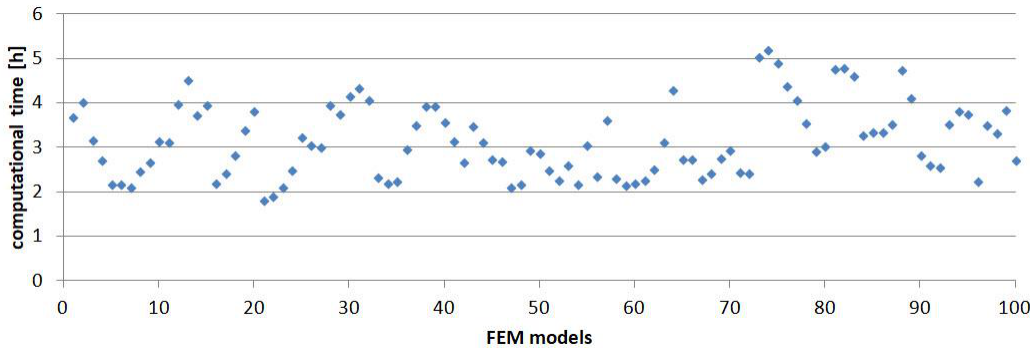
Figure 9. Computational time of FEM models.